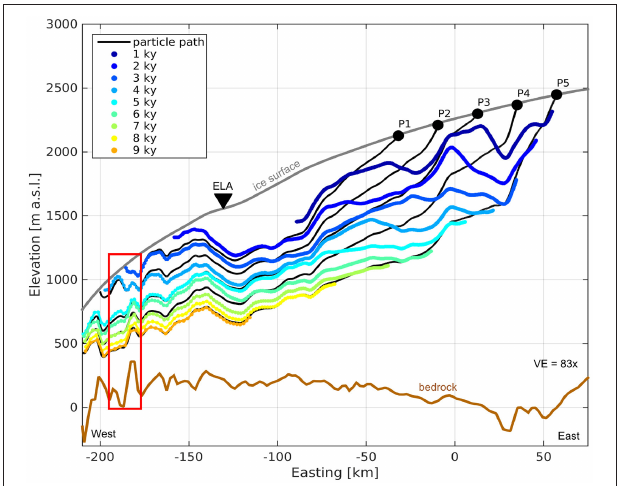
FIGURE 5 | The angle between simulated isochrones and particle paths P1-P5. Results are shown as particles age from deposition near the ice divide (age 0), to emergence near the ice sheet